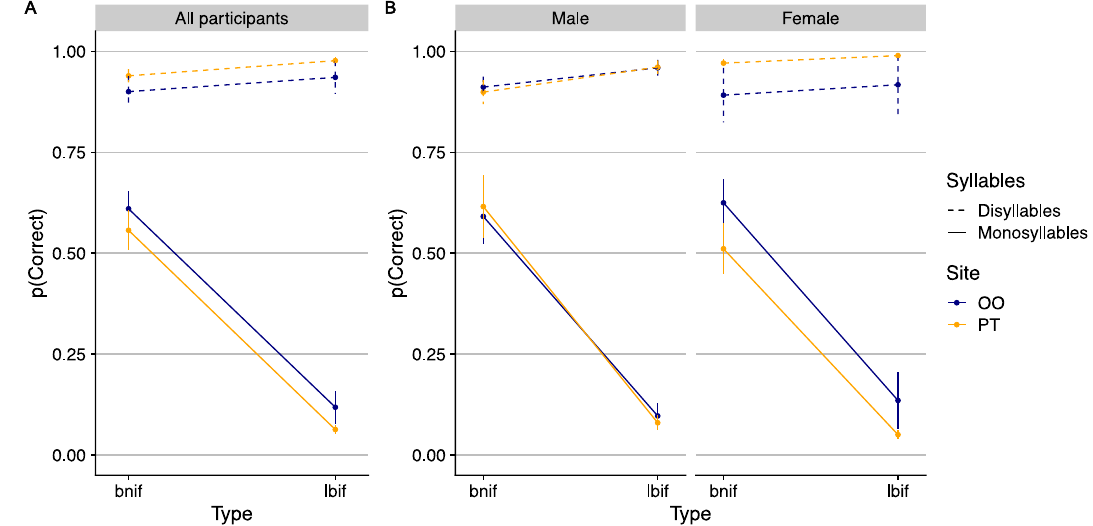
Figure 3. The effect of stimulation on syllable count across participants ( A ) and by gender ( B ). Error bars are SEM. P(Correct) is the proportion of correct